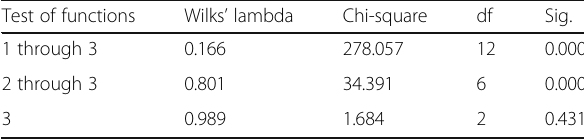
Table 8 Results of Wilks ’ lambda test for verifying differences among populations of A. clupeoides collected from the four sampling sites along the Bay of Bengal coast, Bangladesh Test of functions Wilks ’ lambda Chi-square df